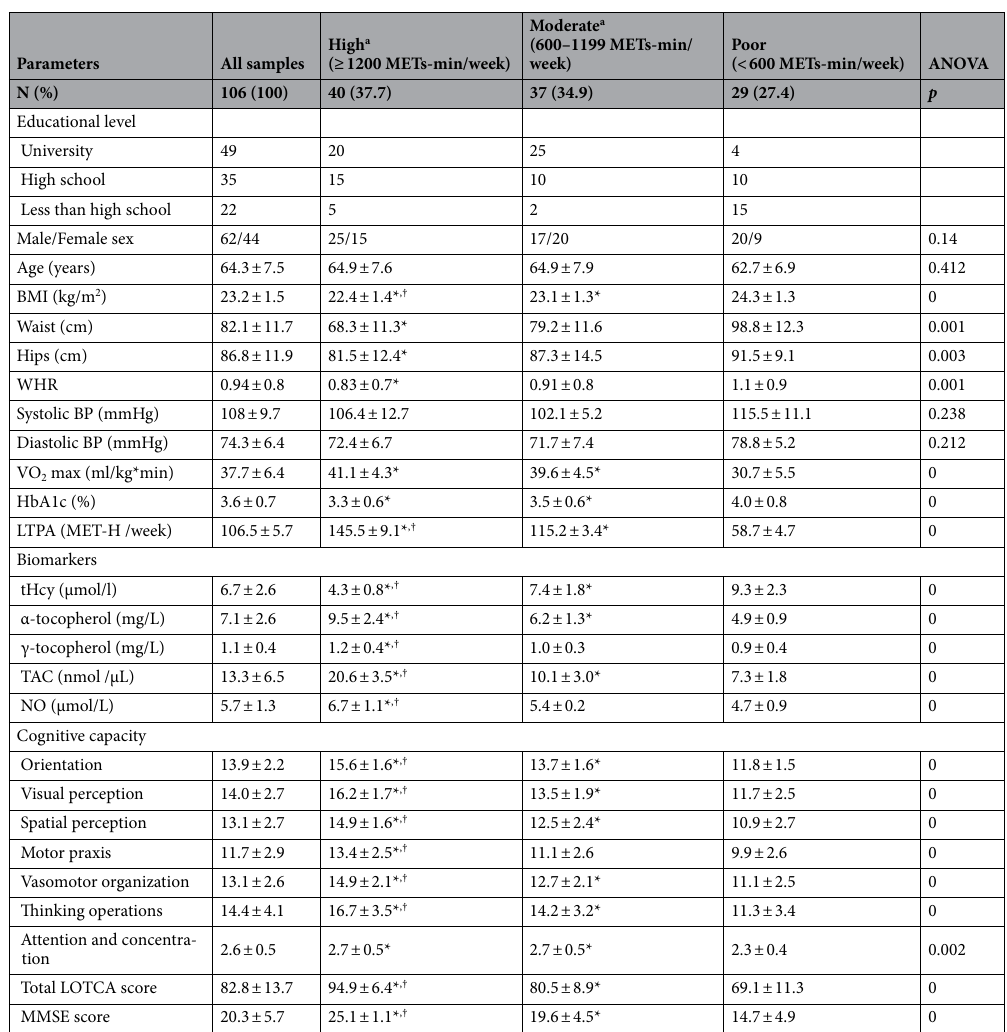
Table 1. Participants characteristics based on the physical activity levels in older adults ( N = 106 ). Values are expressed as a mean ± standard deviation (unadjusted scores). BMI, body mass index; WHR, waist-to- hip ratio; BP, blood pressure; HbA1c, glycated hemoglobin; VO 2 max, maximal oxygen consumption; METs, metabolic equivalents; LTPA, Leisure time physical activity; TAC, total antioxidant capacity (nmol/μL); tHcy, total homocysteine levels (μmol/L); NO, nitric oxide; MMSE, Mini-Mental State Examination; LOTCA, Loewenstein Occupational Therapy Cognitive Assessment. *Significant difference between high or moderate and poor activity levels ( p < 0.05). † Significant difference between high and moderate activity levels ( p < 0.05). a Adjustment for multiple comparisons